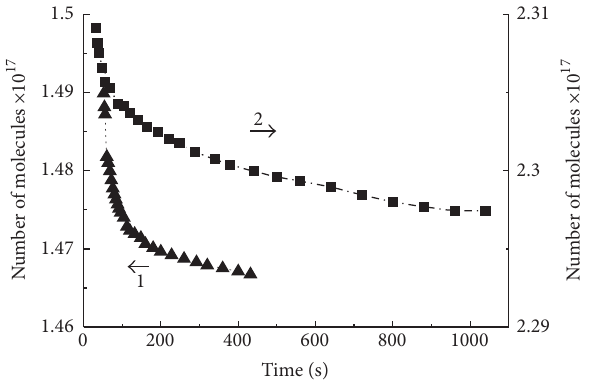
F 3: CO photodesorption kinetics in the presence of Freon 134a (1) and Freon 22 (2) on a powder-like sample produced from a monocrystal. 2 TiO 2 2